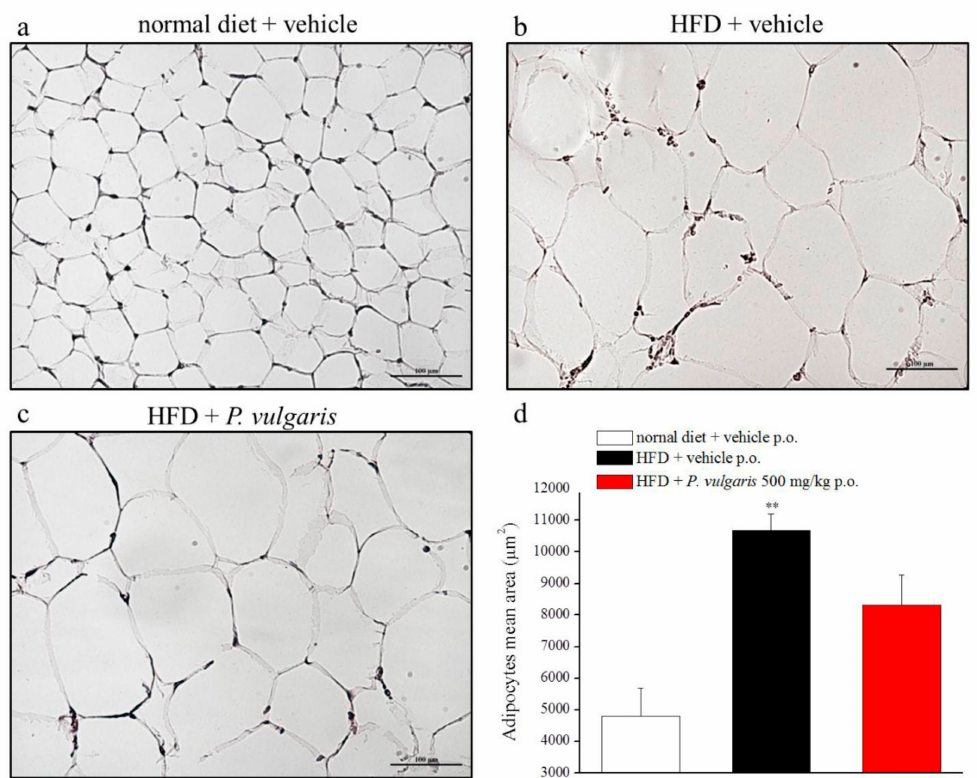
Figure 9. Adipose tissue damage. ( a – d ) E ff ects of diet and P. vulgaris treatment on white adipose tissue. ( a – c ) Representative images of subcutaneous adipose tissue sections stained with hematoxylin-eosin, 20X magnificated. ( d ) Quantitative determination of adipocytes mean area ( µ m 2 ) following HFD or P. vulgaris administration. Each value represents the mean ± S.E.M. of 12 mice per group. ** p < 0.01 vs. normal diet +